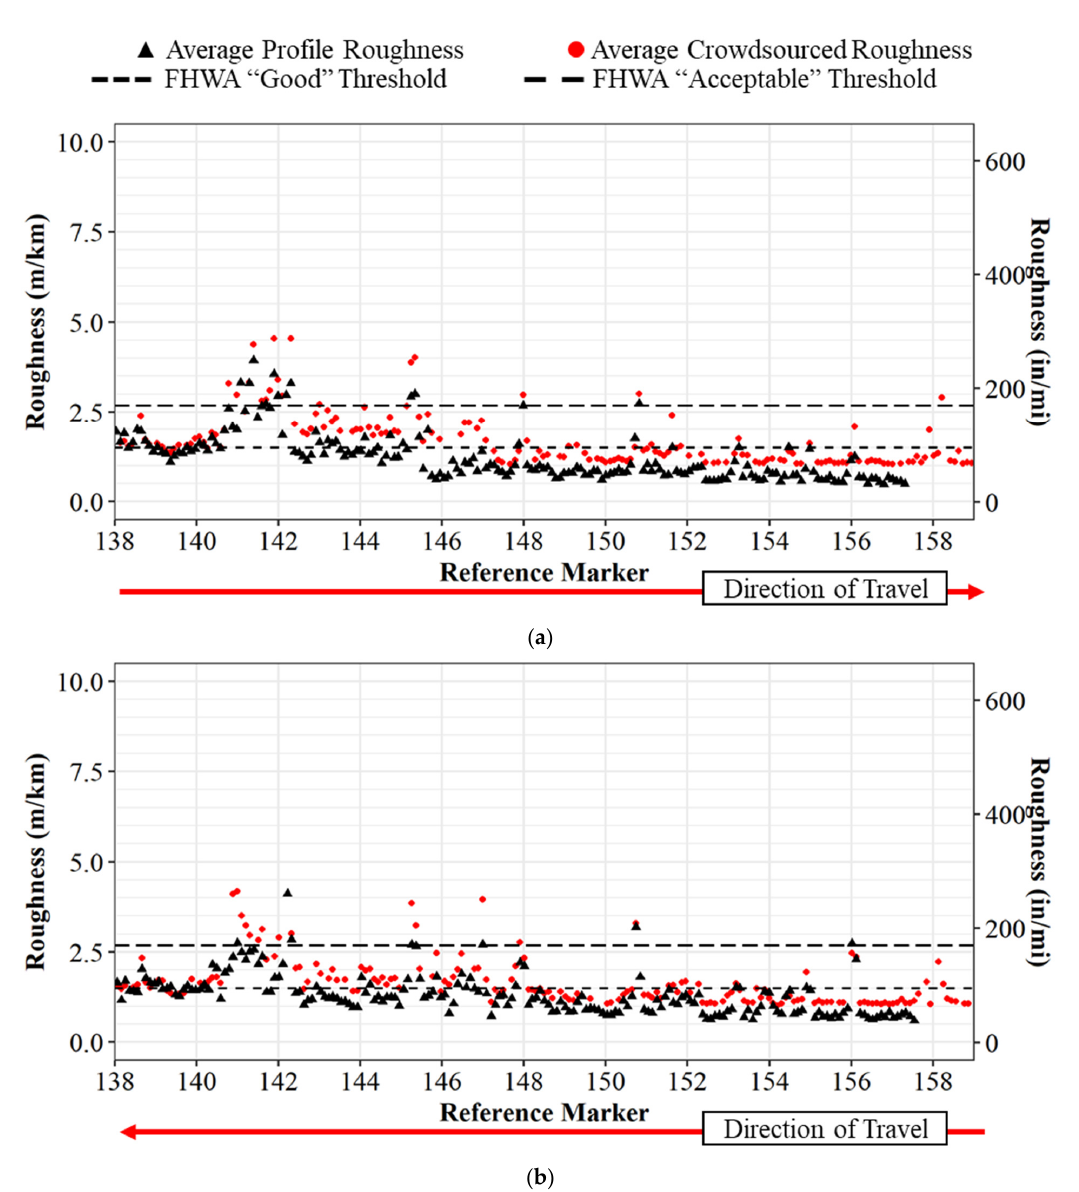
Figure 7. IRI comparison between inertial profiler and crowdsourced roughness for I-65: ( a ) north- bound; ( b ) southbound.